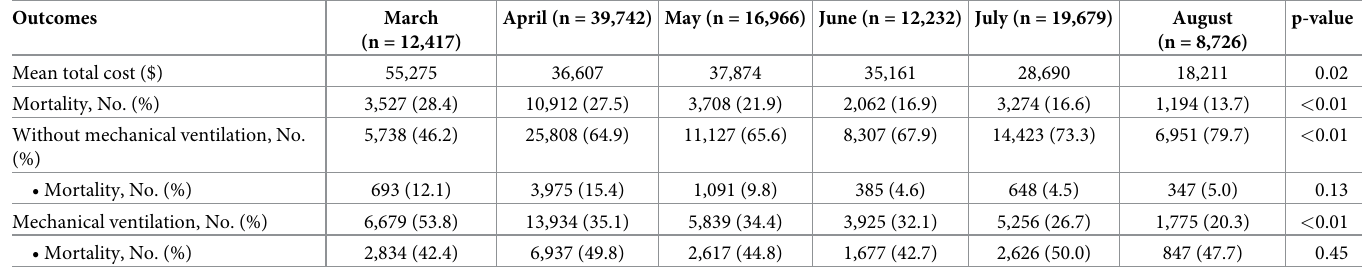
Table 3. Cost, mechanical ventilation, and mortality over time in adults with COVID-19 and acute respiratory distress syndrome or acute respiratory failure. Outcomes